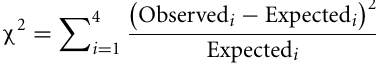
phosphorylationsiteprediction. Figure2 showsROCcurvesof